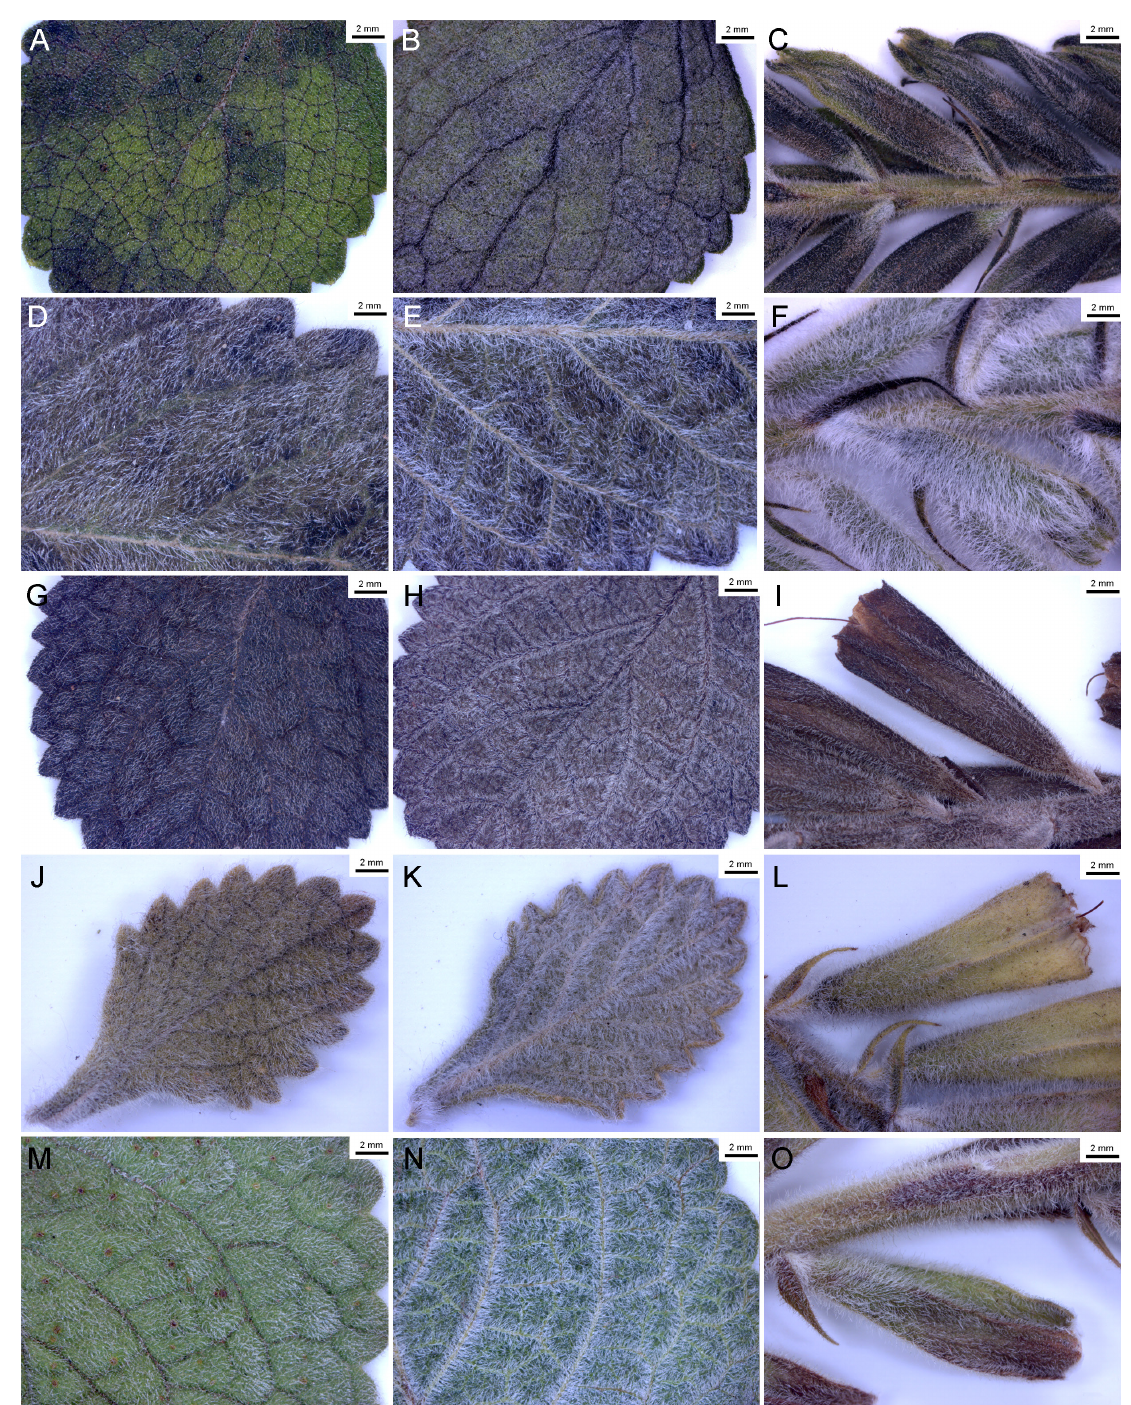
Fig. 6. Comparison between the main characteristics of the species used in the identification key (photos taken under the stereo microscope). A, D, G, J, M . Adaxial indumentum of the leaf-blade. B, E, J,